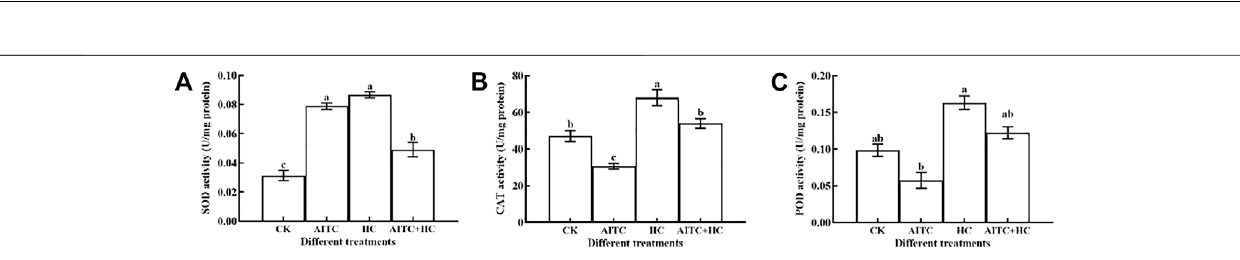
FIGURE 6 | Changes in GST enzyme activity (A) , CarE enzyme activity (B), and Cyt-b5 enzyme (C) activity of B. impatiens after AITC fumigation treatment under ambientCO 2 orhighCO 2 conditionswithandwithoutAITCfumigation.CK:noAITCfumigationunderambientCO 2 condition;AF:AITCfumigation;HC:highCO 2 stress; AF + HC: AITC fumigation under high CO 2 condition. Datarepresent mean ± SD of three replicates. Different lower-case letters indicate statistically signi fi cant difference between sub-lethal concentrations by Tukey ’ s test ( p < 0.05).